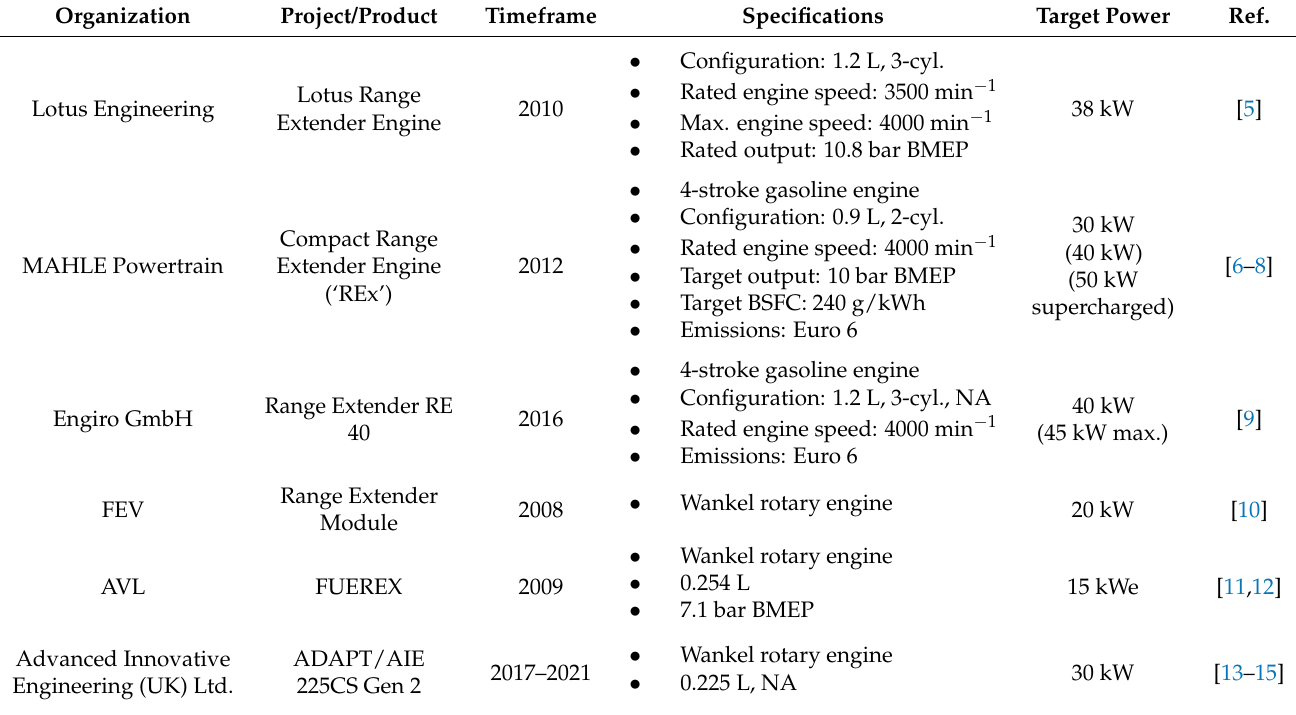
Table 1. Non-exhaustive survey of combustion-based power systems for range extender applications in the literature.